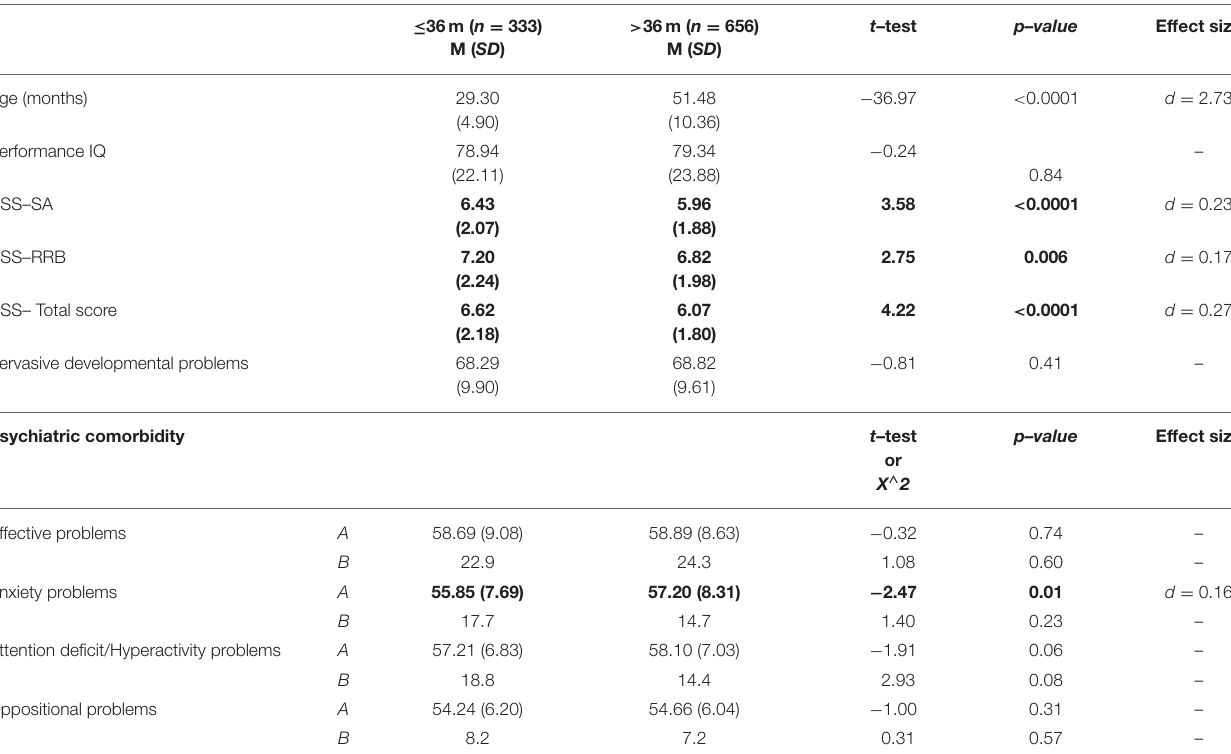
TABLE 7 | Clinical differences between younger ( ≤ 36 months) and older ( > 36 months)